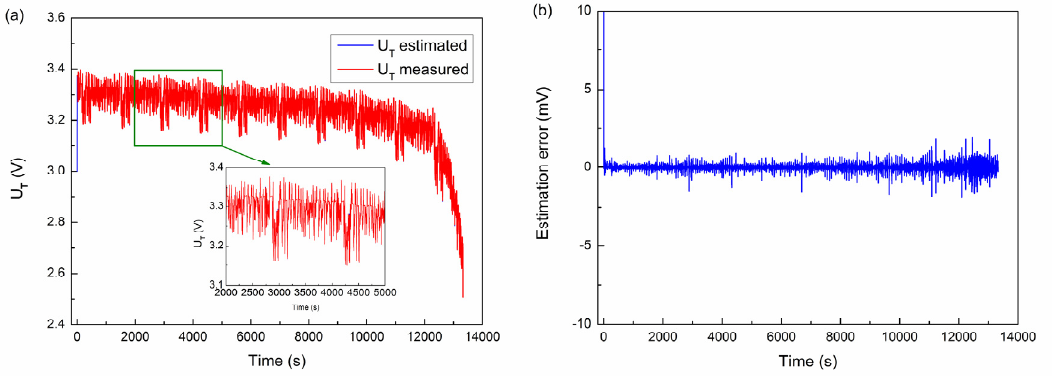
Figure 16. Validation of the identification method in the FUDS test at 40 °C: ( a ) the estimated voltage and measured voltage profiles and ( b ) the estimation error.